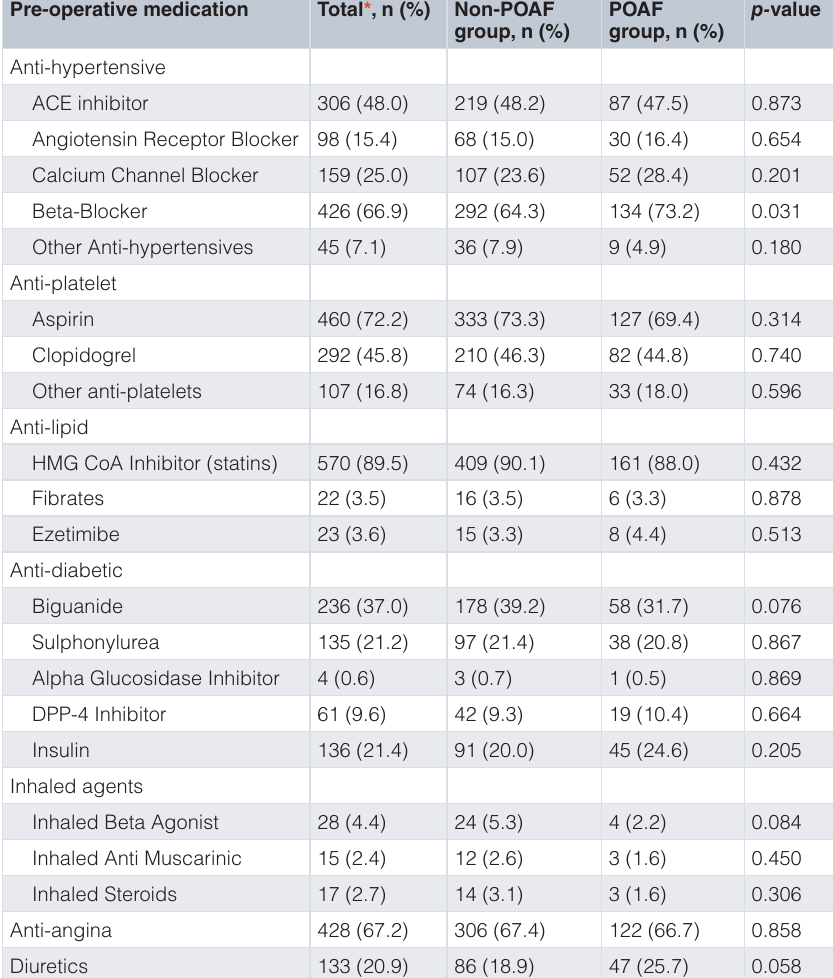
Table 5. List of patient medications on admission, classified into groups. Association between post-operative atrial fibrillation (POAF) and individual medication is presented. Pre-operative